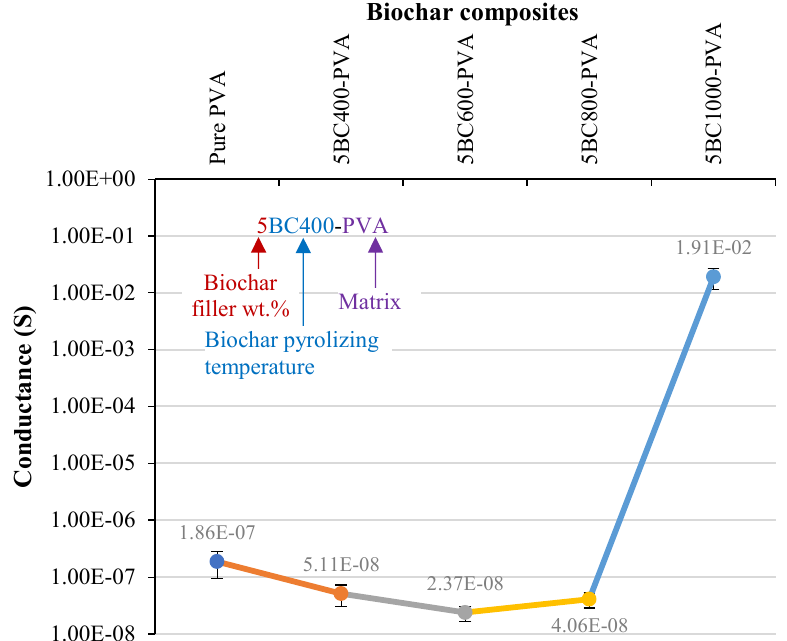
Figure 7. Effect of biochar pyrolyzed at the different temperatures on electrical properties of bio- composite films.